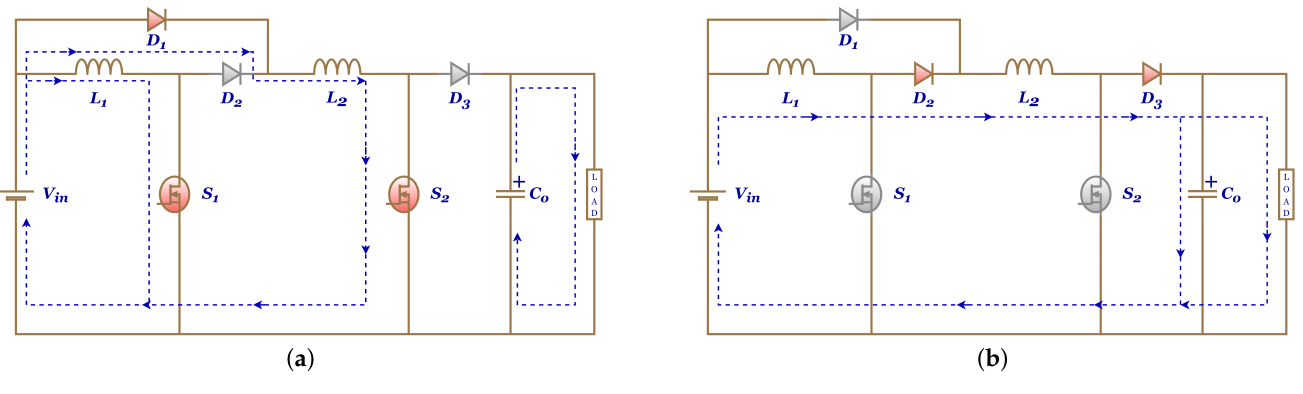
Figure 7. DuBC operation: ( a ) S closed and ( b ) S